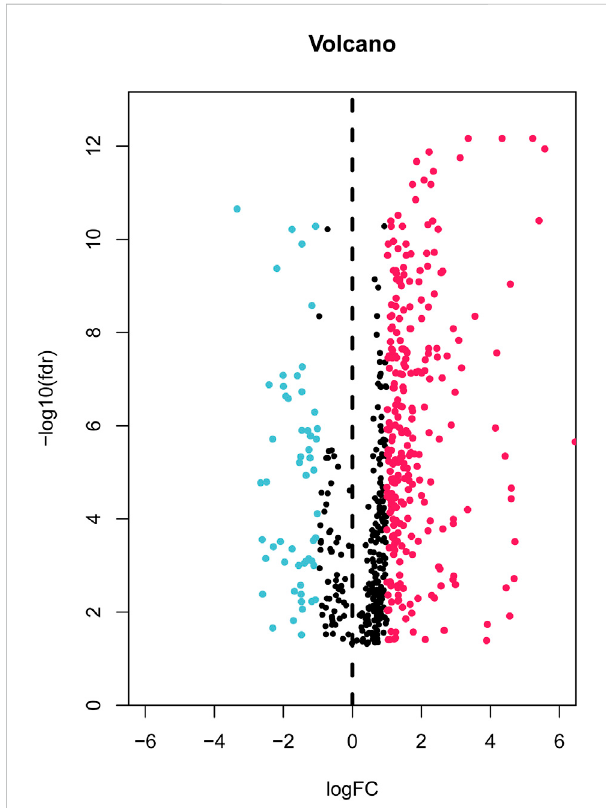
FIGURE 1 Volcano plot of 327 differentially expressed AAMRLs in